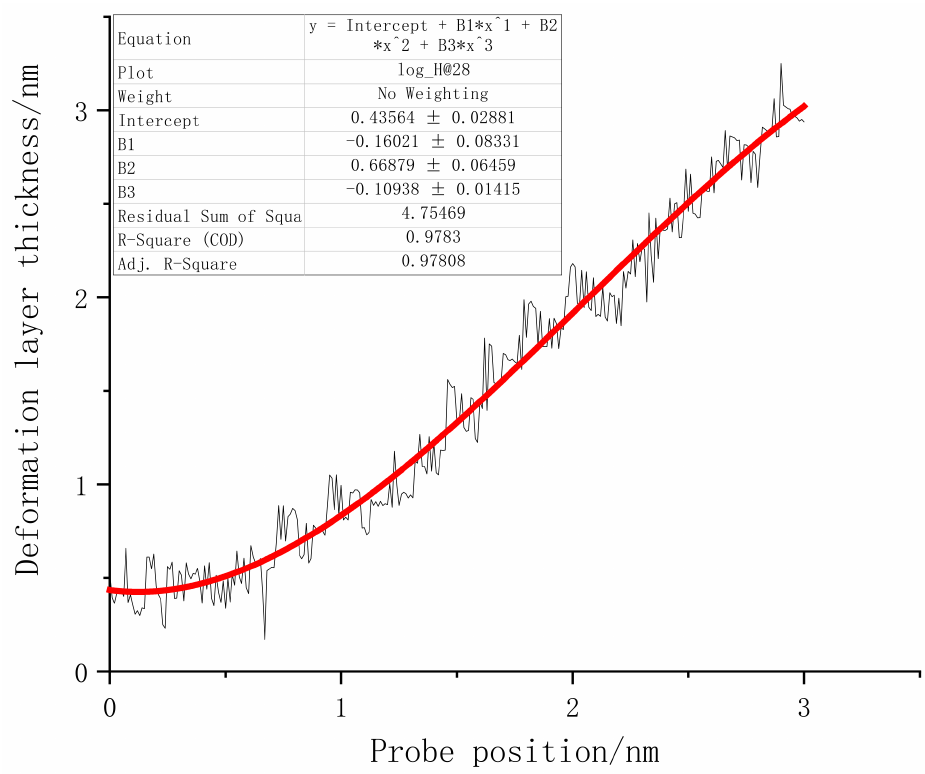
Figure 23. The relationship between the deformation layer and the loading depth when the (110) surface was